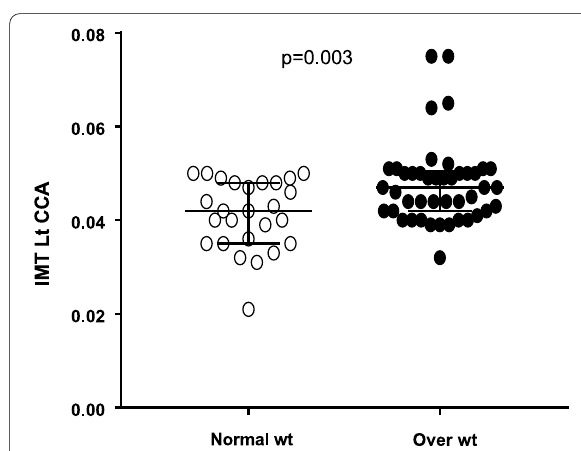
Fig. 2 Student’s T -test comparing the intimal medial thickness in the left common carotid artery with different groups of body mass index, mean value of IMT in normal wt group 0.42 mm, while mean value = of IMT in over wt group 0.49 mm =